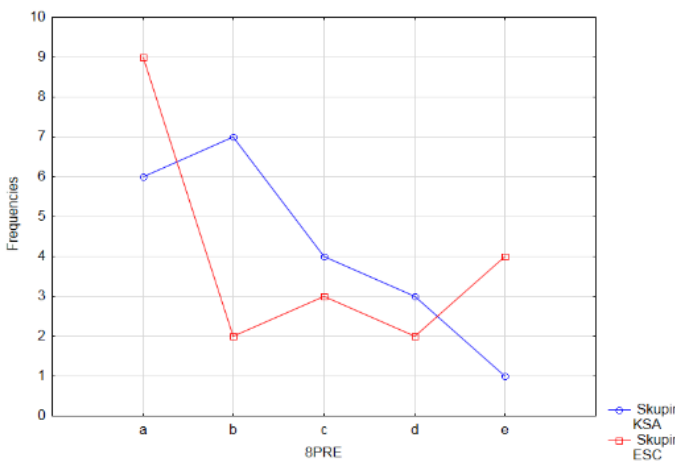
Figure 17. Interaction graph of the eighth item of the pretest - 8PRE.